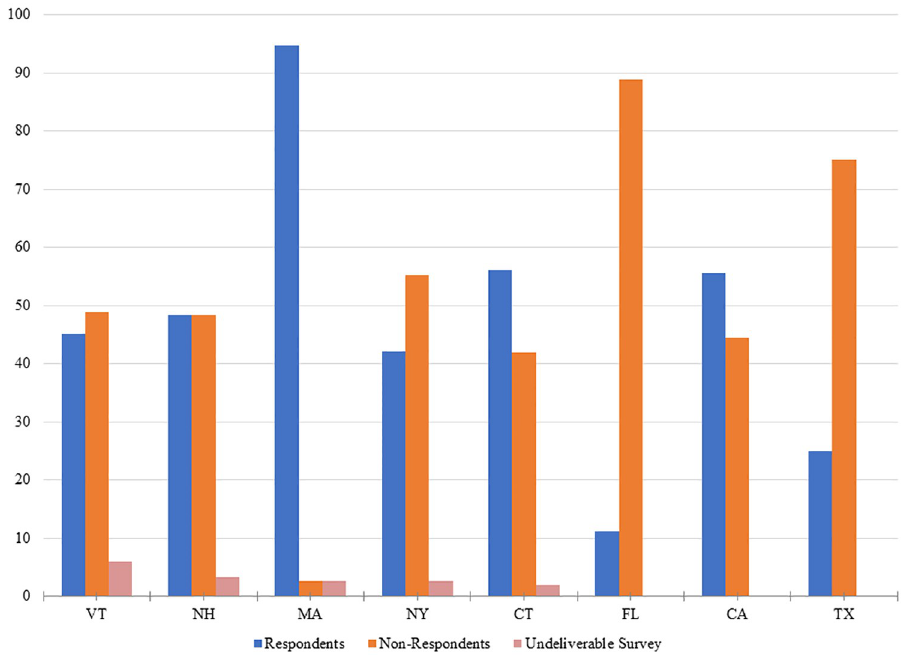
Fig 2. Percent respondents, non-respondents, and undeliverable surveys by state of residence of landowner in survey sample.